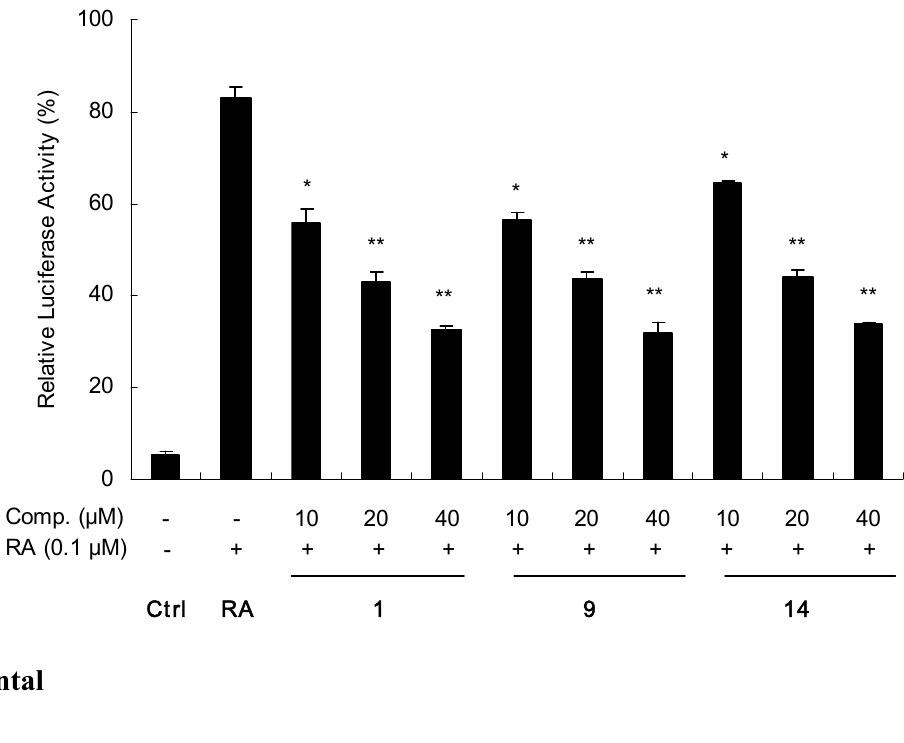
Figure 5. Inhibitory effects of compounds 1 , 9 and 14 on reporter transcription activities of RXR α in concentration-dependent